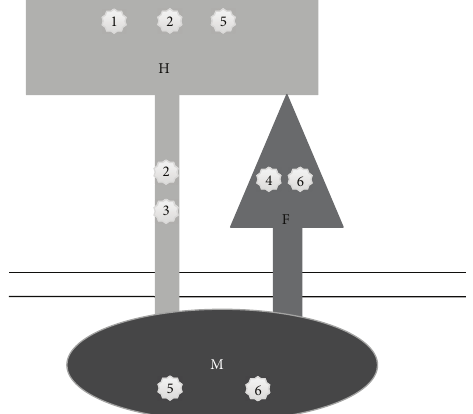
Figure 9: Schematic representation of the MV hemagglutinin (H), fusion (F), and matrix (M) proteins. The localization of the muta- tions responsible for the immune escape for each of the mutants (numbers1–6) dissected is indicated by the mutant’s